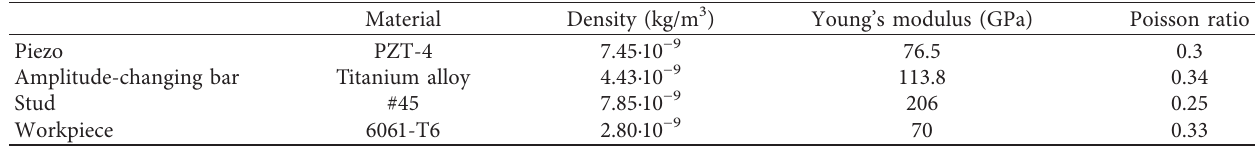
Figure 7: General assembly diagram of the UVARM system. Table 1: Material properties.